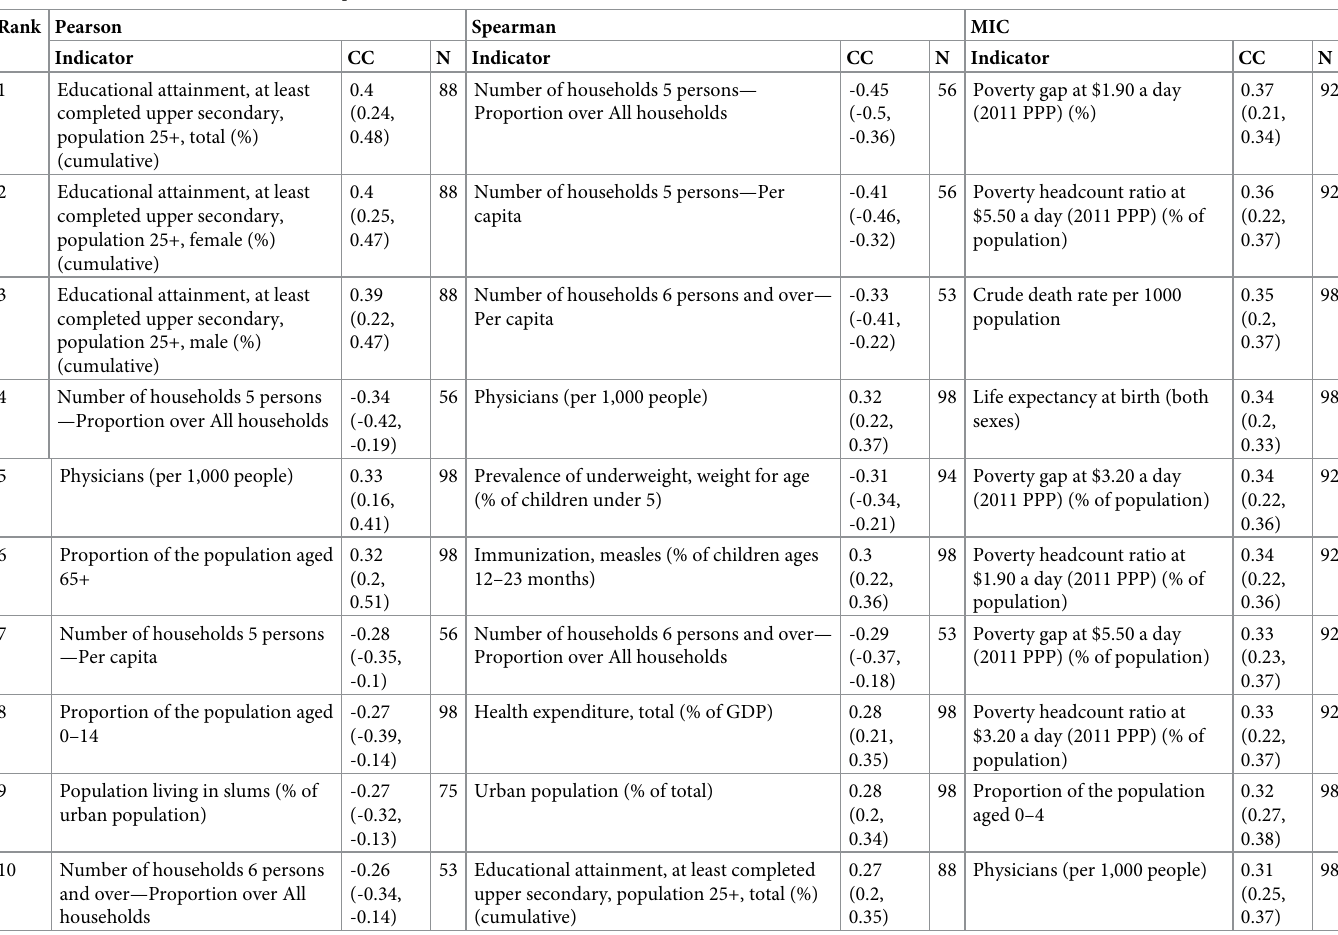
Table 1. Summary of the top ten correlation coefficients and MIC for the association between the basic reproduction number and the indicators, obtained consider- ing estimates of the basic reproduction number for all countries. The columns labelled “CC” hold the coefficient, with the 95% range obtained by bootstrapping; the col- umn labelled “N” holds the number of data points used to calculate the